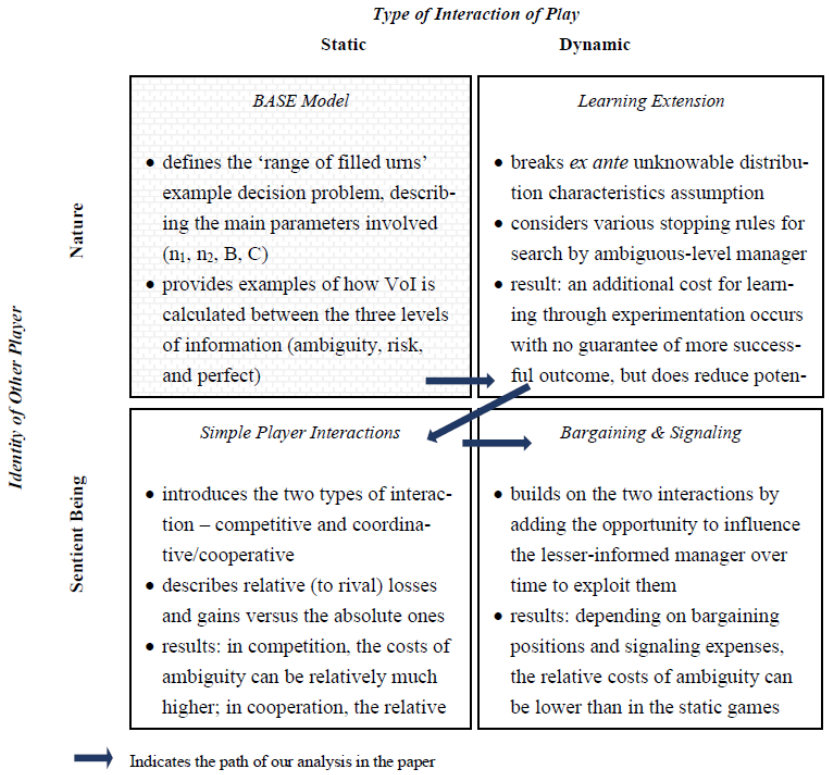
Figure 1. Outline of the Analysis of the Costs of Ambiguity in Strategic Decisions.